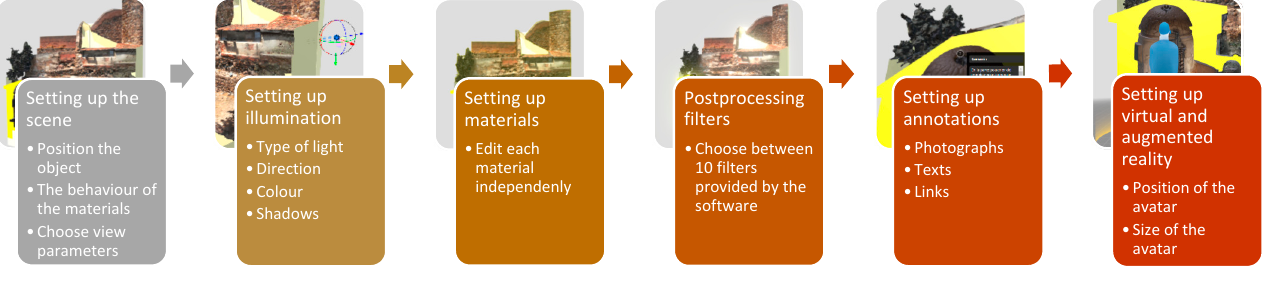
Figure 12. Postprocessing workflow.